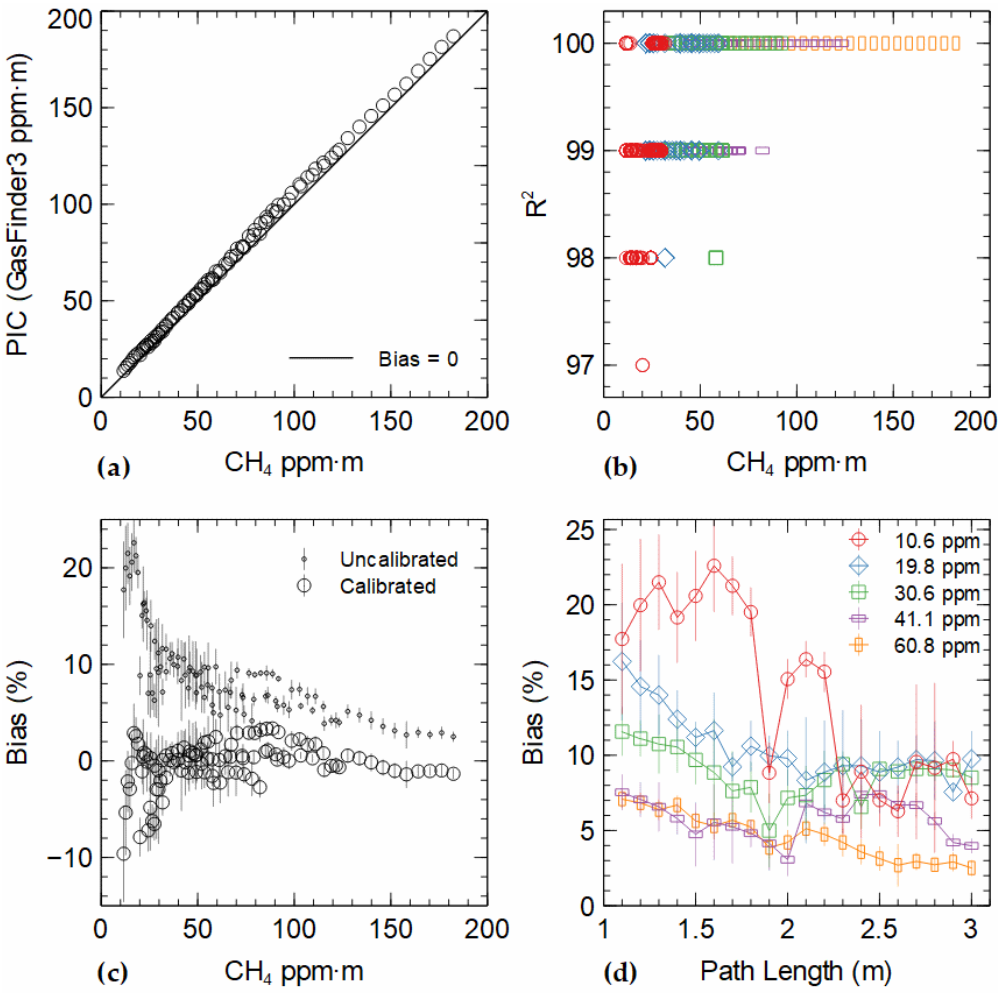
Figure 2. Plots of ( a ) GF3-measured and expected path-integrated concentrations (PIC, ppm · m), and a 1:1 line, ( b ) goodness of fit (R 2 ) between GF3-measured sample signal and internal reference cell versus path-integrated concentration, ( c ) relative bias before and after applying a linear calibration to the measured concentrations, over the range of expected CH 4 path-integrated concentrations, and ( d ) relative bias before linear calibration, over the range of path lengths for each standard gas concentration. Bias was determined against standard gas concentrations and the measurement path-length. Error bars in ( c ) and ( d ) are standard deviations calculated from replicate samples. To correct the observed bias, a linear equation was used: C = 0.97793 × M − 2.8843 (r 2 = 0.9992), where C is the corrected and M is the measured ppm · m value. After calibration, the